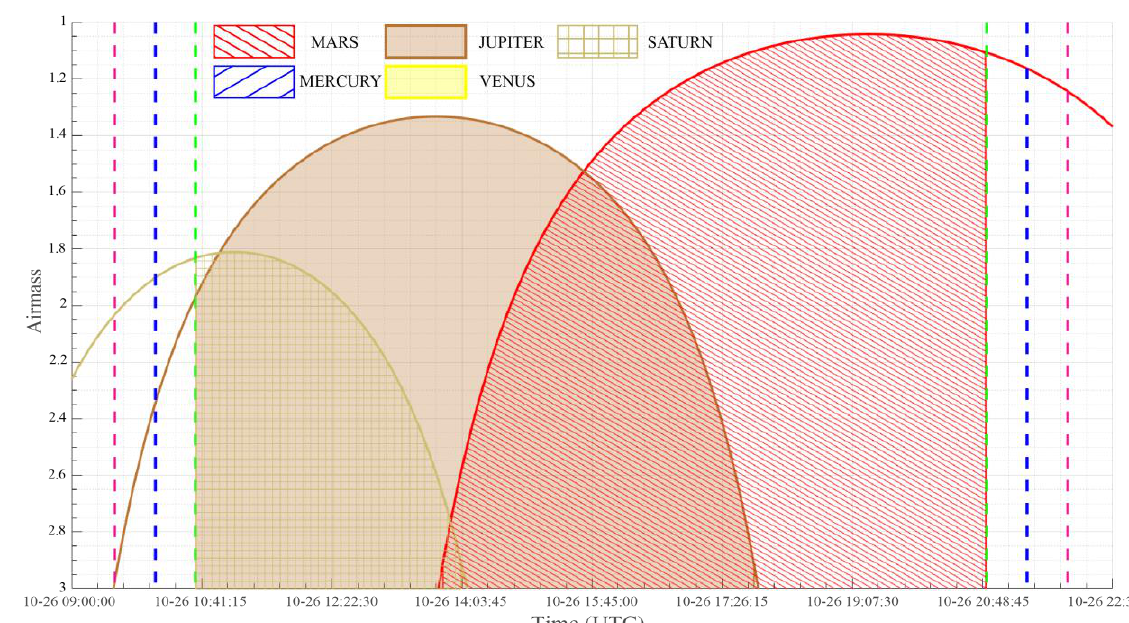
Figure 6. Observation windows on 26 October 2022. Information is shown in the same format as in Figure 4.